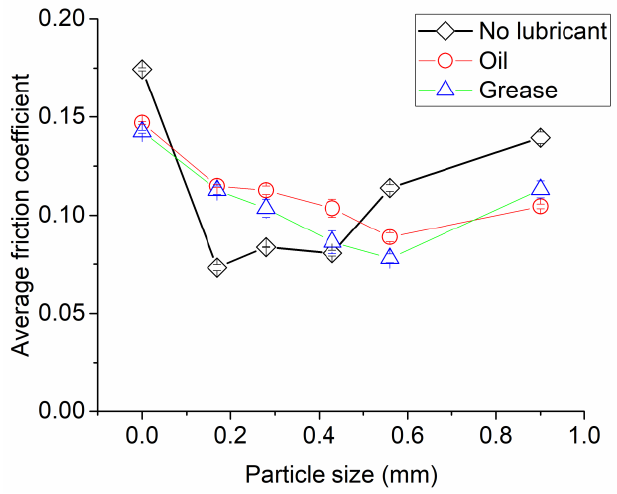
Figure 4. Average friction coefficient of straw powder with different particle sizes under various lubrication conditions.